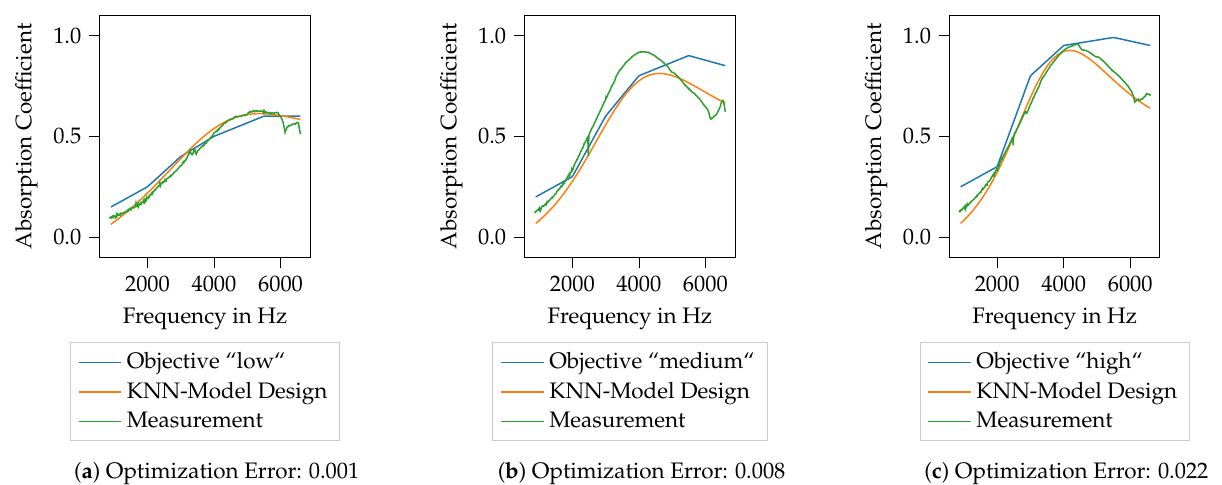
Figure 16. Design of porous media using an KNN machine-learning model for three different target curves. It can be seen that, especially for the targets “low” and “high” the predictions are met with high accuracy. However, the KNN model is not able to extrapolate from the know data range, as the prediction does not follow the target curves for “medium” and “high” above approx.